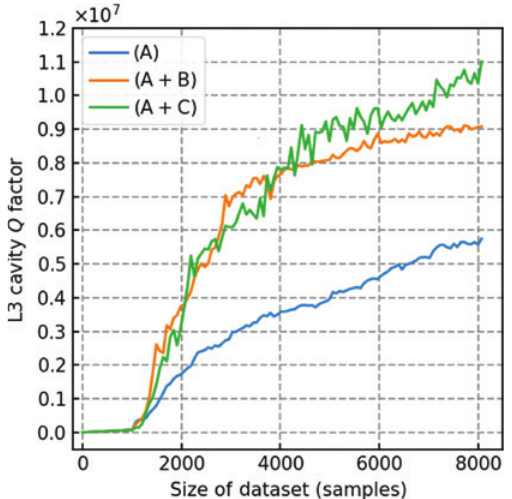
Figure 4: The highest Q factor of the additional 70 sample cavities generated in one round as a function of the size of the